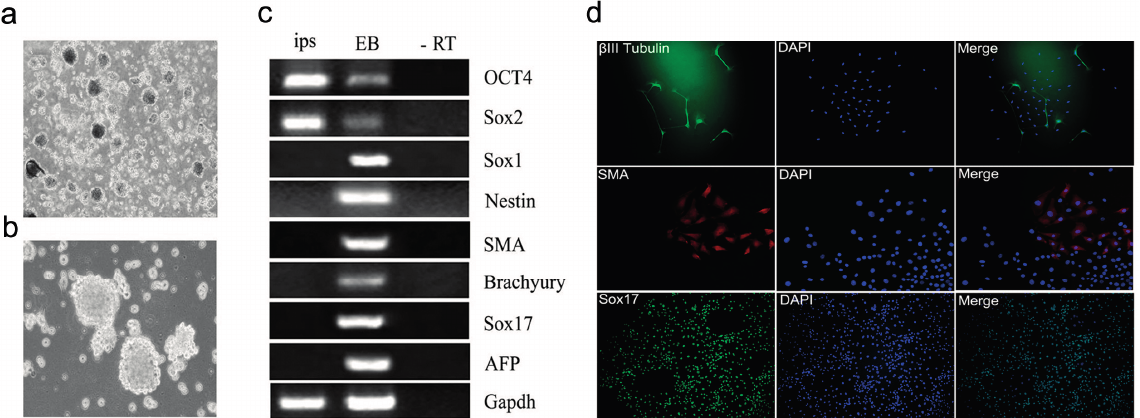
Figure 9. Pluripotency of the generated mRNA iPS from mouse MEF cells. ( a , b ) Assess pluripotency of the derived iPSCs; the cells were induced to form embryoid bodies (EB). The EB morphology in suspension culture ( a , magnification 40×) ( b , magnification 100×); ( c ) Comparative gene expression profiles of iPSCs and EB, using RT-PCR and showing that levels of pluripotent stem cell markers (Oct4, Sox2 ) decreased in EB while ectodermal markers ( Sox1 , Nestin ), mesodermal markers (smooth muscle actin ( SMA ), brachyury ) and endodermal markers (Sox17, AFP) were highly expressed in EB cells; ( d ) Immuno-staining confirming in vitro differentiation into three germ layers; β III tubulin (ectodermal), SMA (mesodermal), and Sox17 (endodermal). Secondary antibodies were labeled with Alexa 488 (green, 40×) and Cy3 (red, 100×); ( e ) Hematoxylin and eosin staining of teratoma sections generated from mRNA iPSCs; (i) pigmented epithelium (ectoderm); (ii) epidermal tissue (ectoderm); (iii) cartilage like structure, fat and muscle tissues (mesoderm); (iv) epithelium (endoderm) 100×; ( f ) normal karyotyping and chromosomes numbers of mRNA